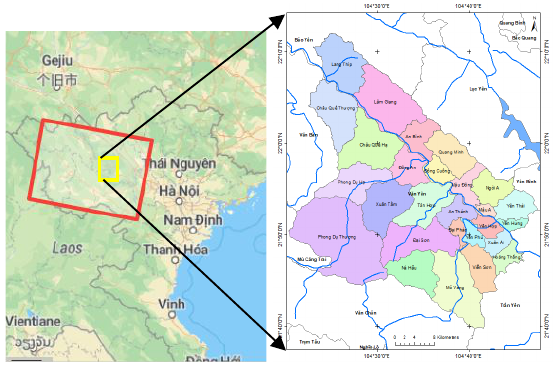
Figure 1. The red rectangle is the Sentinel-1 frame of the Yenbai area on the map of Vietnam, The yellow rectangle is the frame of Van Yen district.